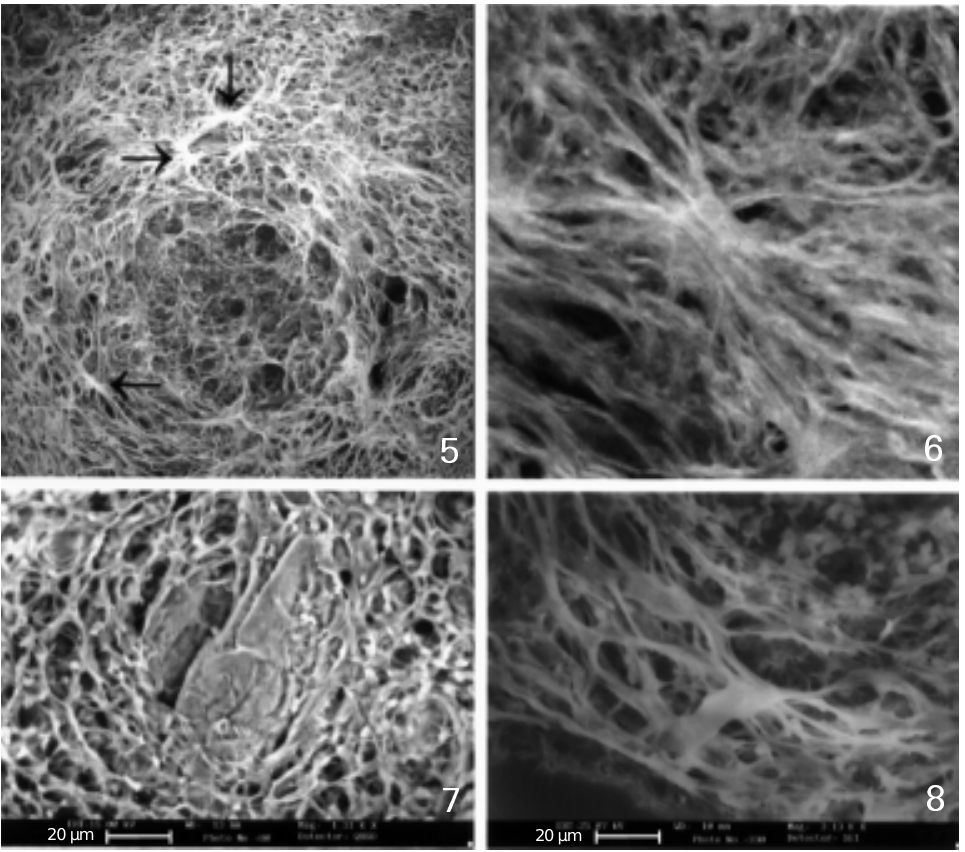
Figure 5 - Exudative-productive stage with intense fiber com- pactness, clearly showing sev- eral fiber anchorage points (fiber radiation centers) (arrows).